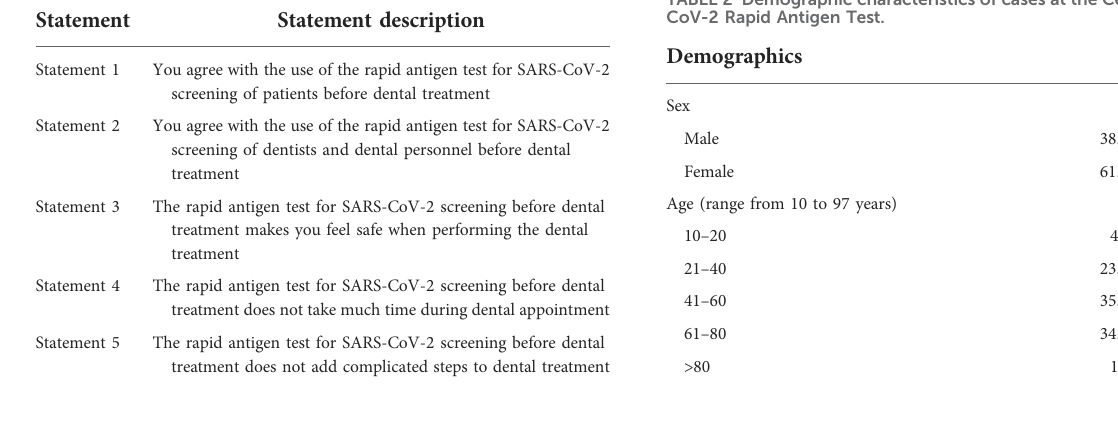
TABLE 1 Questions displayed in the second section of the self- administered questionnaire.